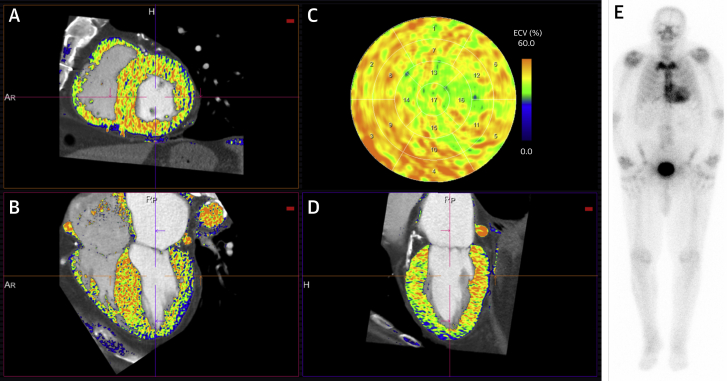
Automated ECVCT Heart Model Output With Corresponding 3-h Planar DPD ImageECVCT map superimposed on the CTCA images (A to D) and corresponding 3-h planar DPD image (E). The endocardial and epicardial contours can be edited in the short-axis (A), 4-chamber (B), and 2-chamber (D) views to produce an ECVCT American Heart Association 17-segment polar map (C). This is a patient with aortic stenosis (AS) amyloid (Perugini grade 2 99mTc-3,3-diphosphono-1,2-propanodicarboxylic acid [DPD] scintigraphy) with total myocardial ECVCT is globally elevated at 47%. Abbreviations as in Figure 1.